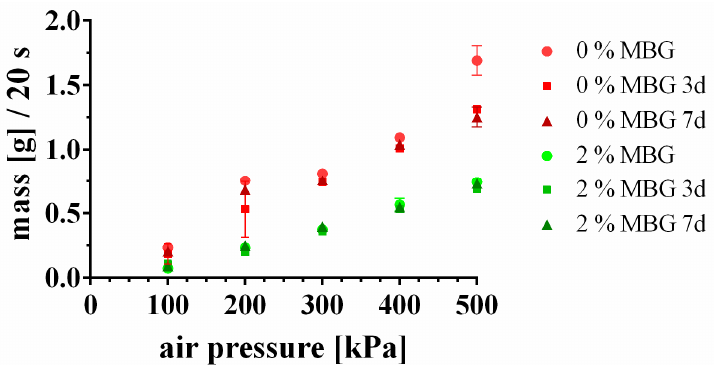
Figure 1. Storability of a pure CPC paste (0%-MBG) and a MBG-CPC composite (2%-MBG-CPC). The extruded mass flow profiles through a 610 µ m needle did not change over 7 d, indicating that storability was not impaired by incorporation of MBG. (mean ± standard deviation, n =